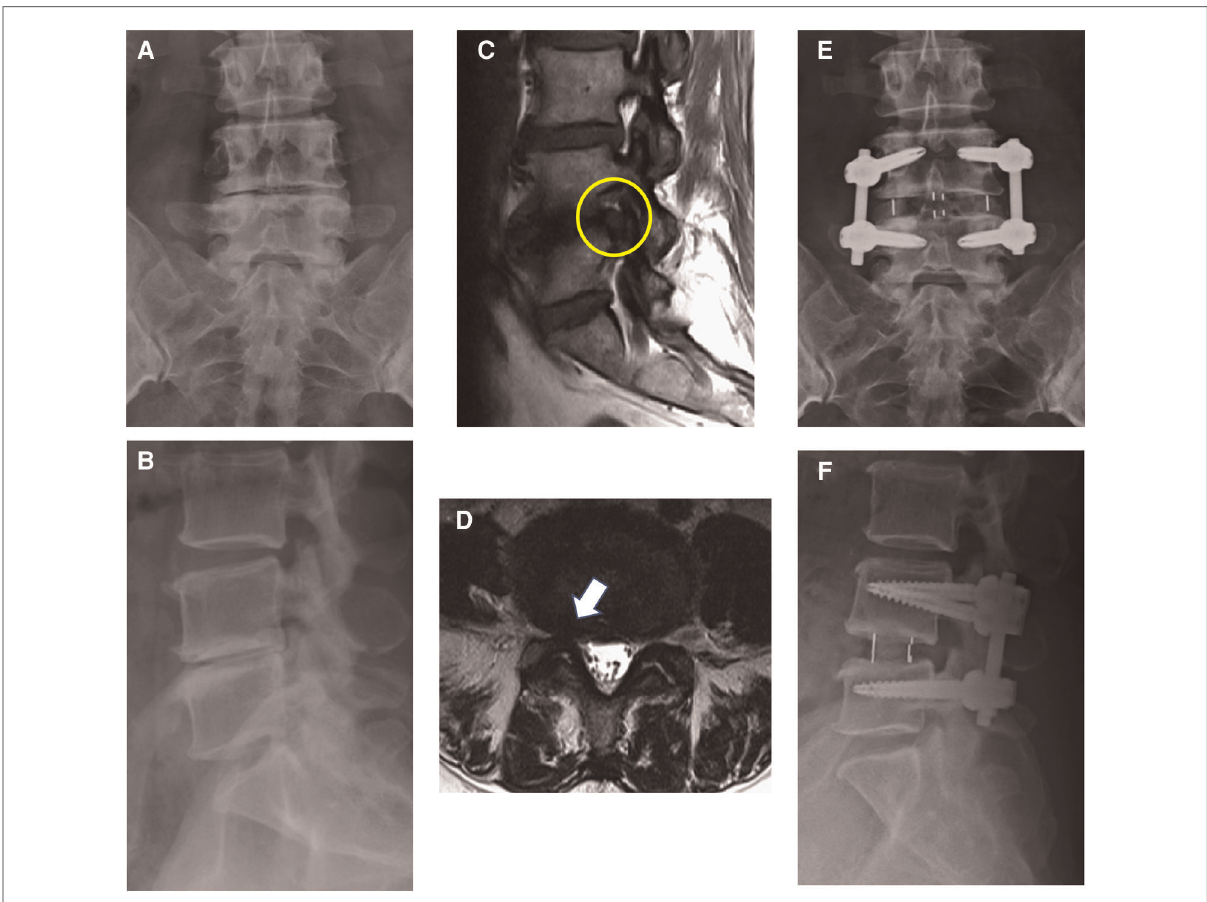
FIGURE 1 Anterior – posterior view ( A ) and lateral view ( B ) of a 67-year-old woman with degenerative disc disease. Sagittal T1-weighted MRI ( C ) and axial T2- weighted MRI ( D ) showed foraminal stenosis of L4/L5 (yellow circle and white arrow). Postoperative anterior – posterior view ( E ) and lateral view ( F ) of this patient. OLIF, L4/L5, with posterior instrumentation was